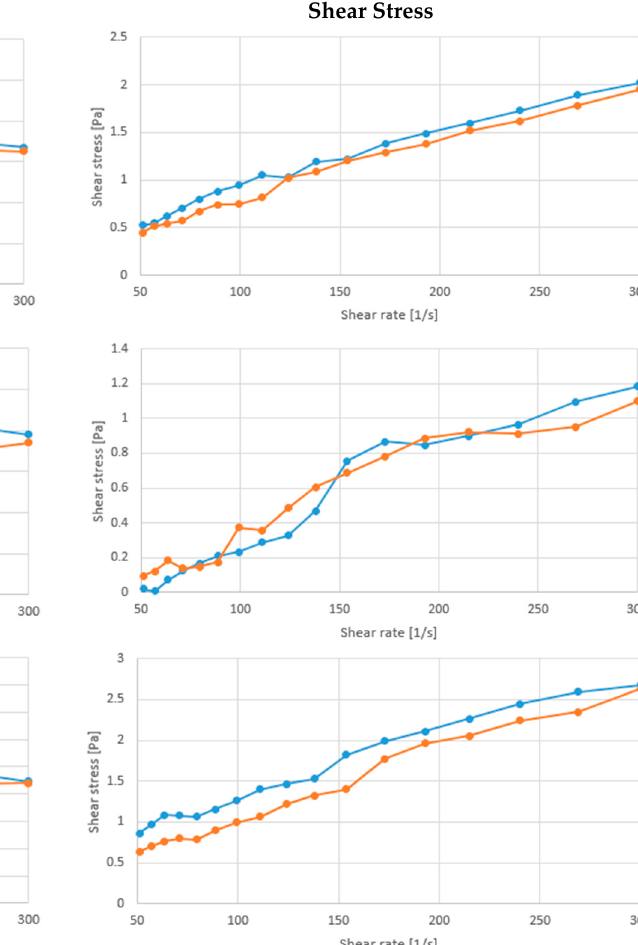
Figure 3. Relationship between viscosity/shear stress and shear rate at 20 °C of the samples with ( a ) Soy drink + L. fermentum, ( b ) Soy drink + L. fermentum + Xylitol , ( c ) Soy drink + L. fermentum + C. vulgaris + Xylitol (experiments effectuated in duplicate red and blue line).